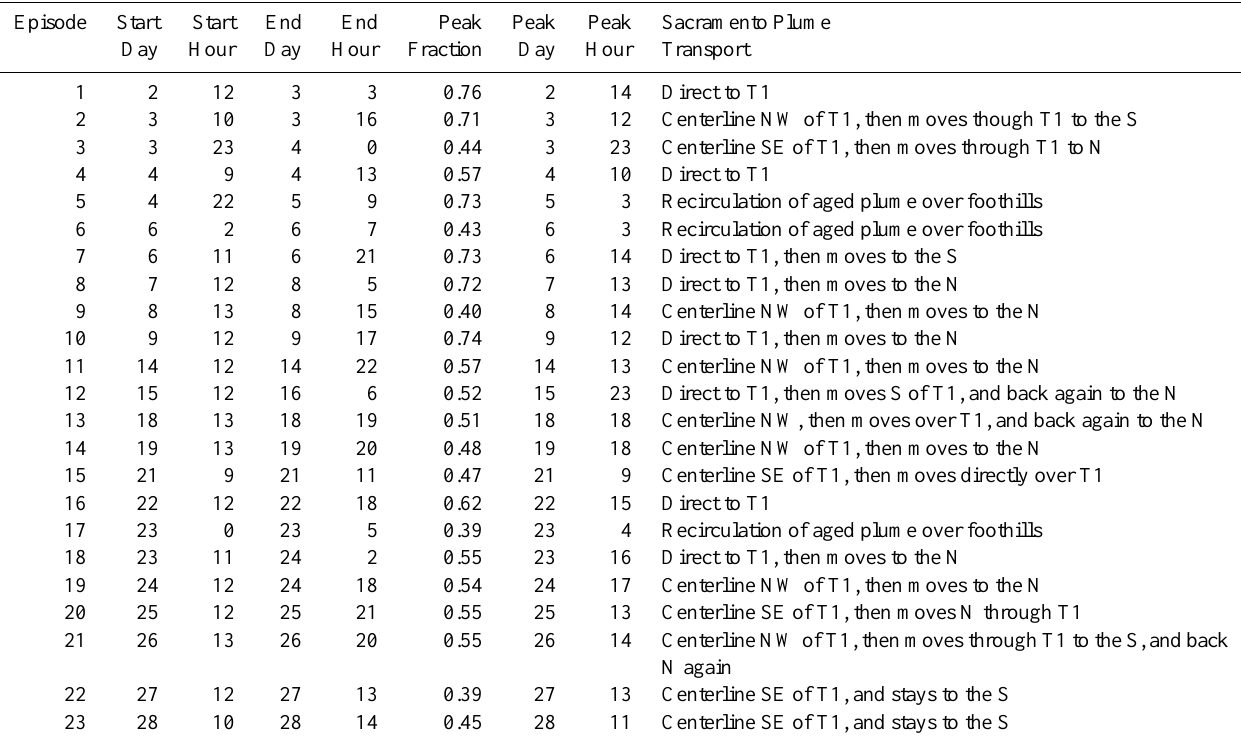
Table 4. Periods (LST) when the simulated fraction of CO from Sacramento sources at the T1 site is greater than 30%, indicating periods of transport from Sacramento to